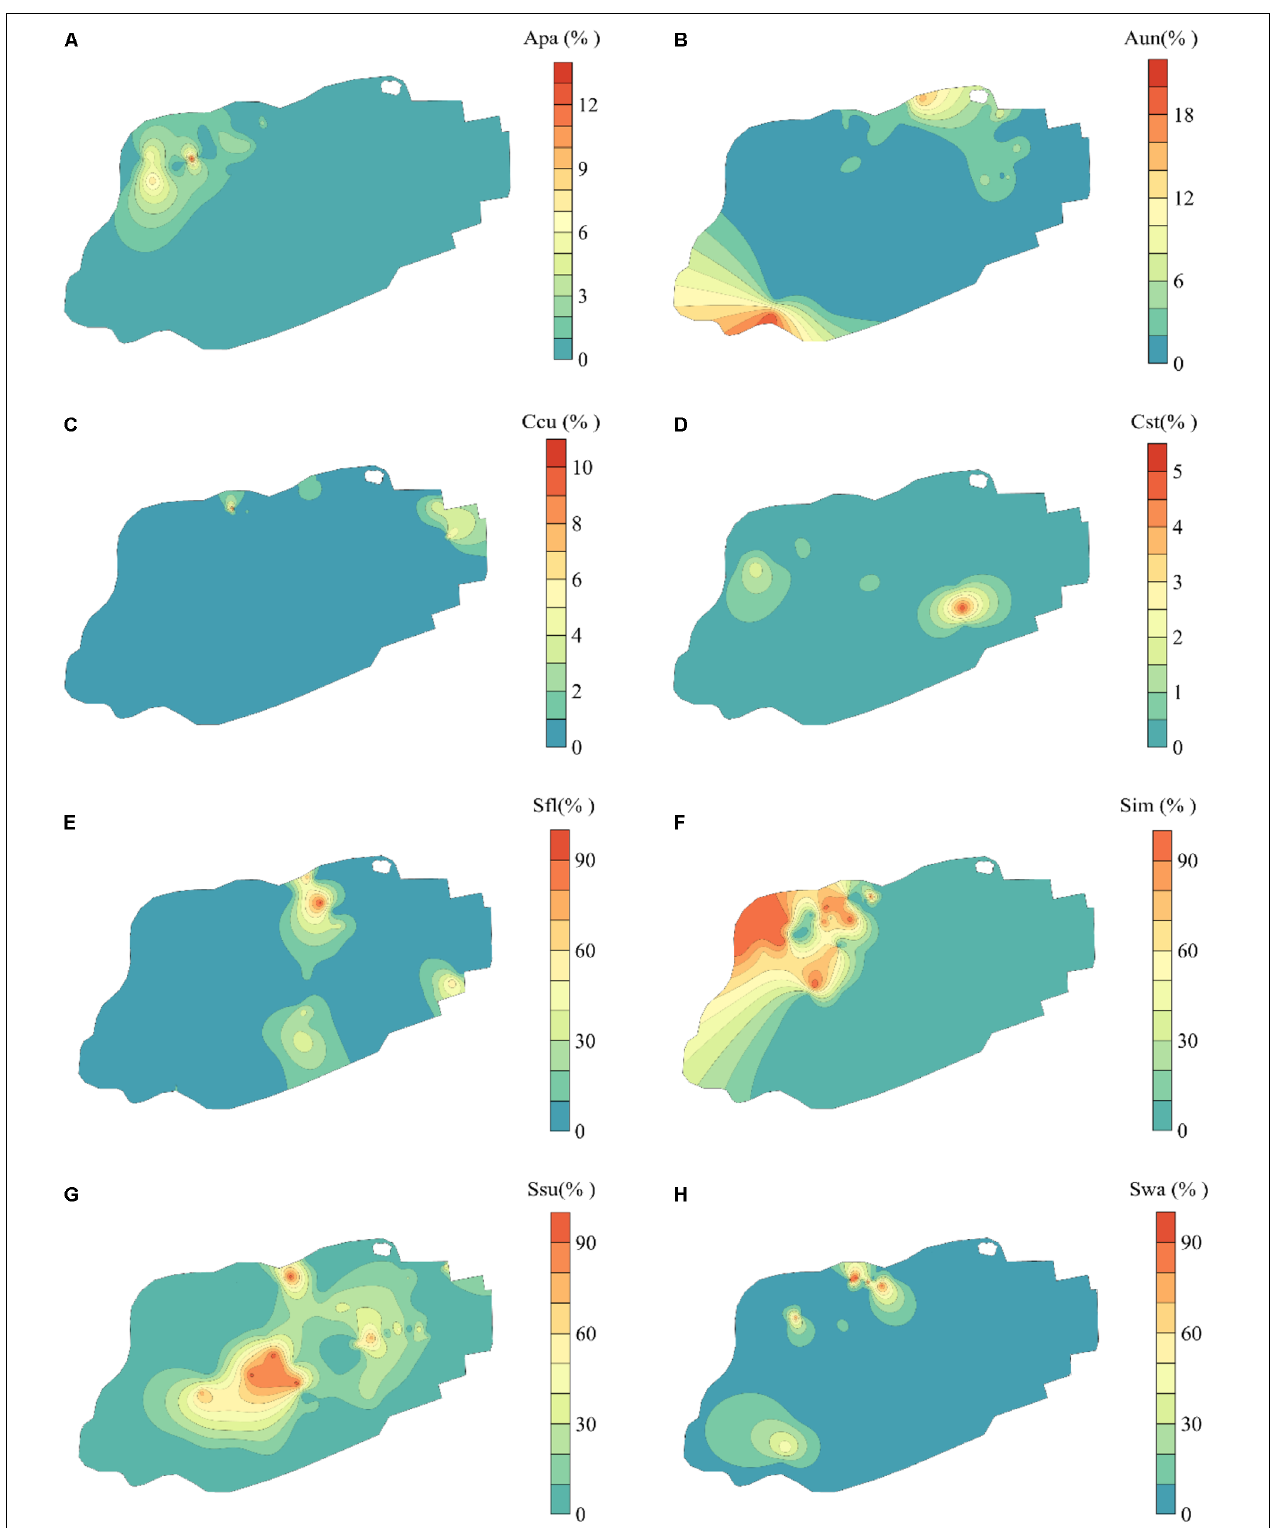
FIGURE 3 | Spatial distribution of bryophytes in Jinchuan mire based on Kriging interpolation. (A) Aulacomnium palustre (Apa). (B) Atrichum undulatum (Aun). (C) Calliergonella cuspidata (Ccu). (D) Campylium stellatum (Cst). (E) Sphagnum flexuosum (Sfl). (F) S. imbricatum (Sim). (G) S. subsecundum (Ssu). (H) S. warnstorfii (Swa). The part of bryophyte cover less than 0 fitted by Kriging interpolation has been replaced with 0.